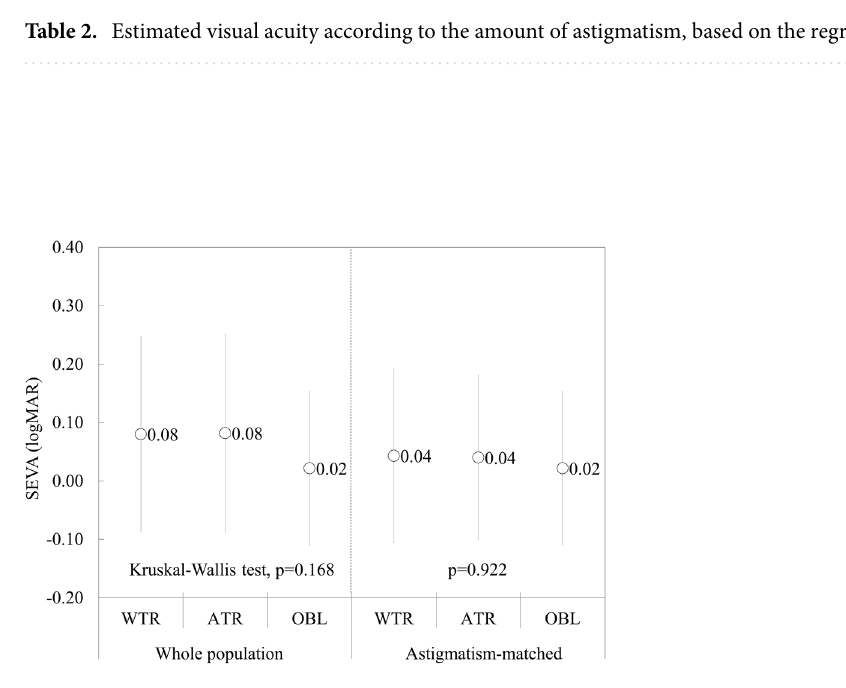
Figure 3. Graphs showing the spherical equivalent visual acuity (SEVA) according to the axis orientation in the entire study population and astigmatism-matched groups. (Kruskal–Wallis test, p = 0.168, and p = 0.922,